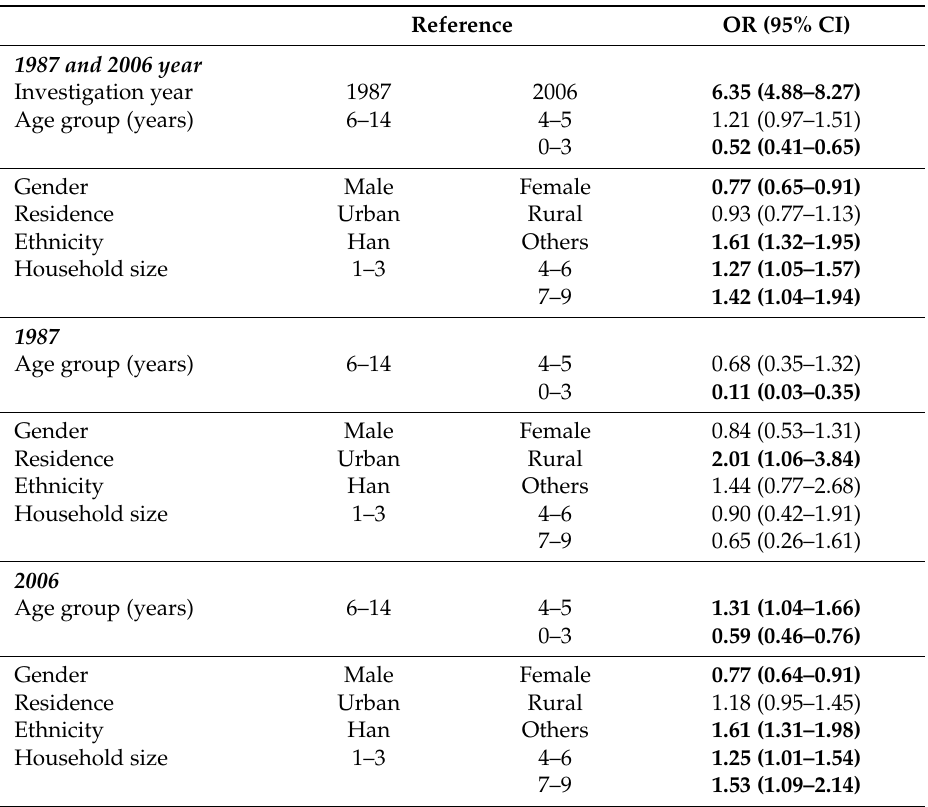
Table 5. Associations of psychiatric disability in Chinese